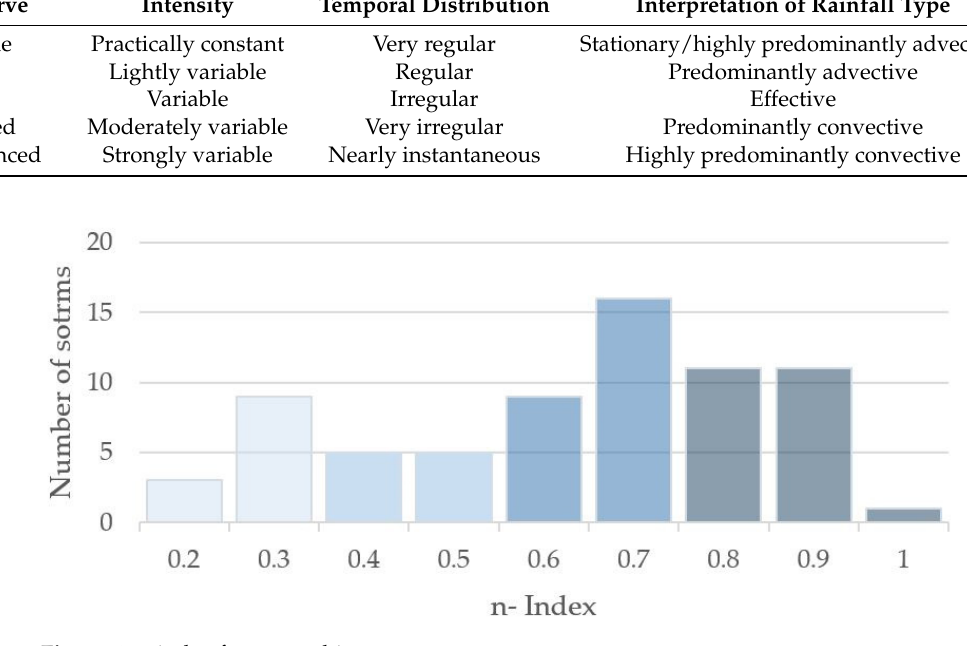
Figure 4. n-index frequency histogram.